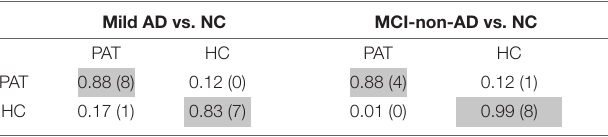
TABLE 3 | Confusion matrices for the two binary classification problems. Mild AD vs. NC